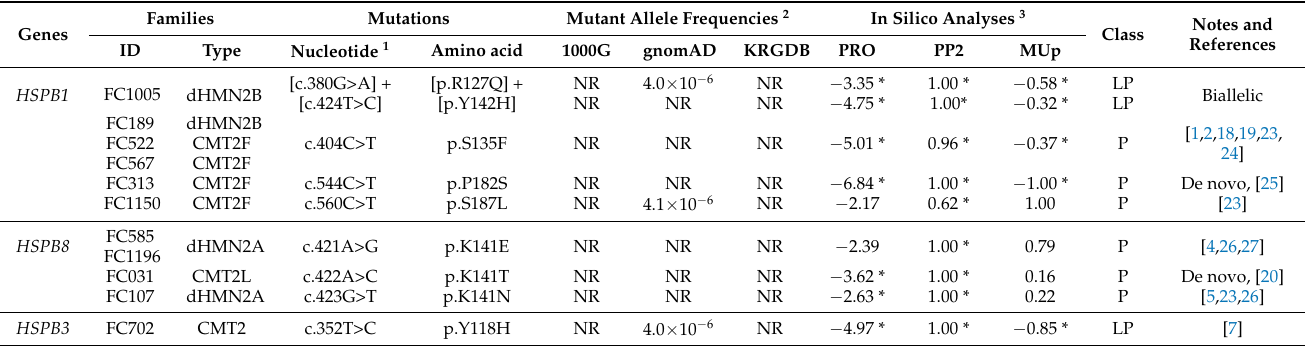
Table 1. Disease-causing variants identified from HSPB1 , HSPB8 , and HSPB3 in Korean inherited peripheral neuropathy patients.